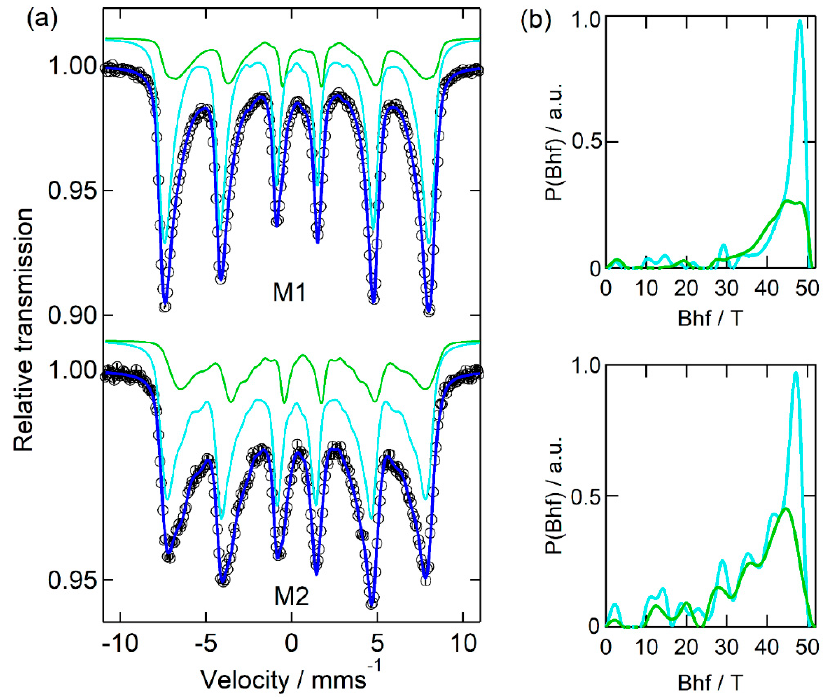
Figure 3. ( a ) Mossbauer experimental spectra (open circles) and fitted curves (blue lines) of the as- prepared MNP M1 and M2 (without additives). Cyan and green lines correspond to the contributions of the magnetic hyperfine interactions in site 1 and site 2, respectively, associated with different oxidation states of iron. The corresponding distributions of the magnetic hyperfine fields are plotted in ( b ), using the same colours.